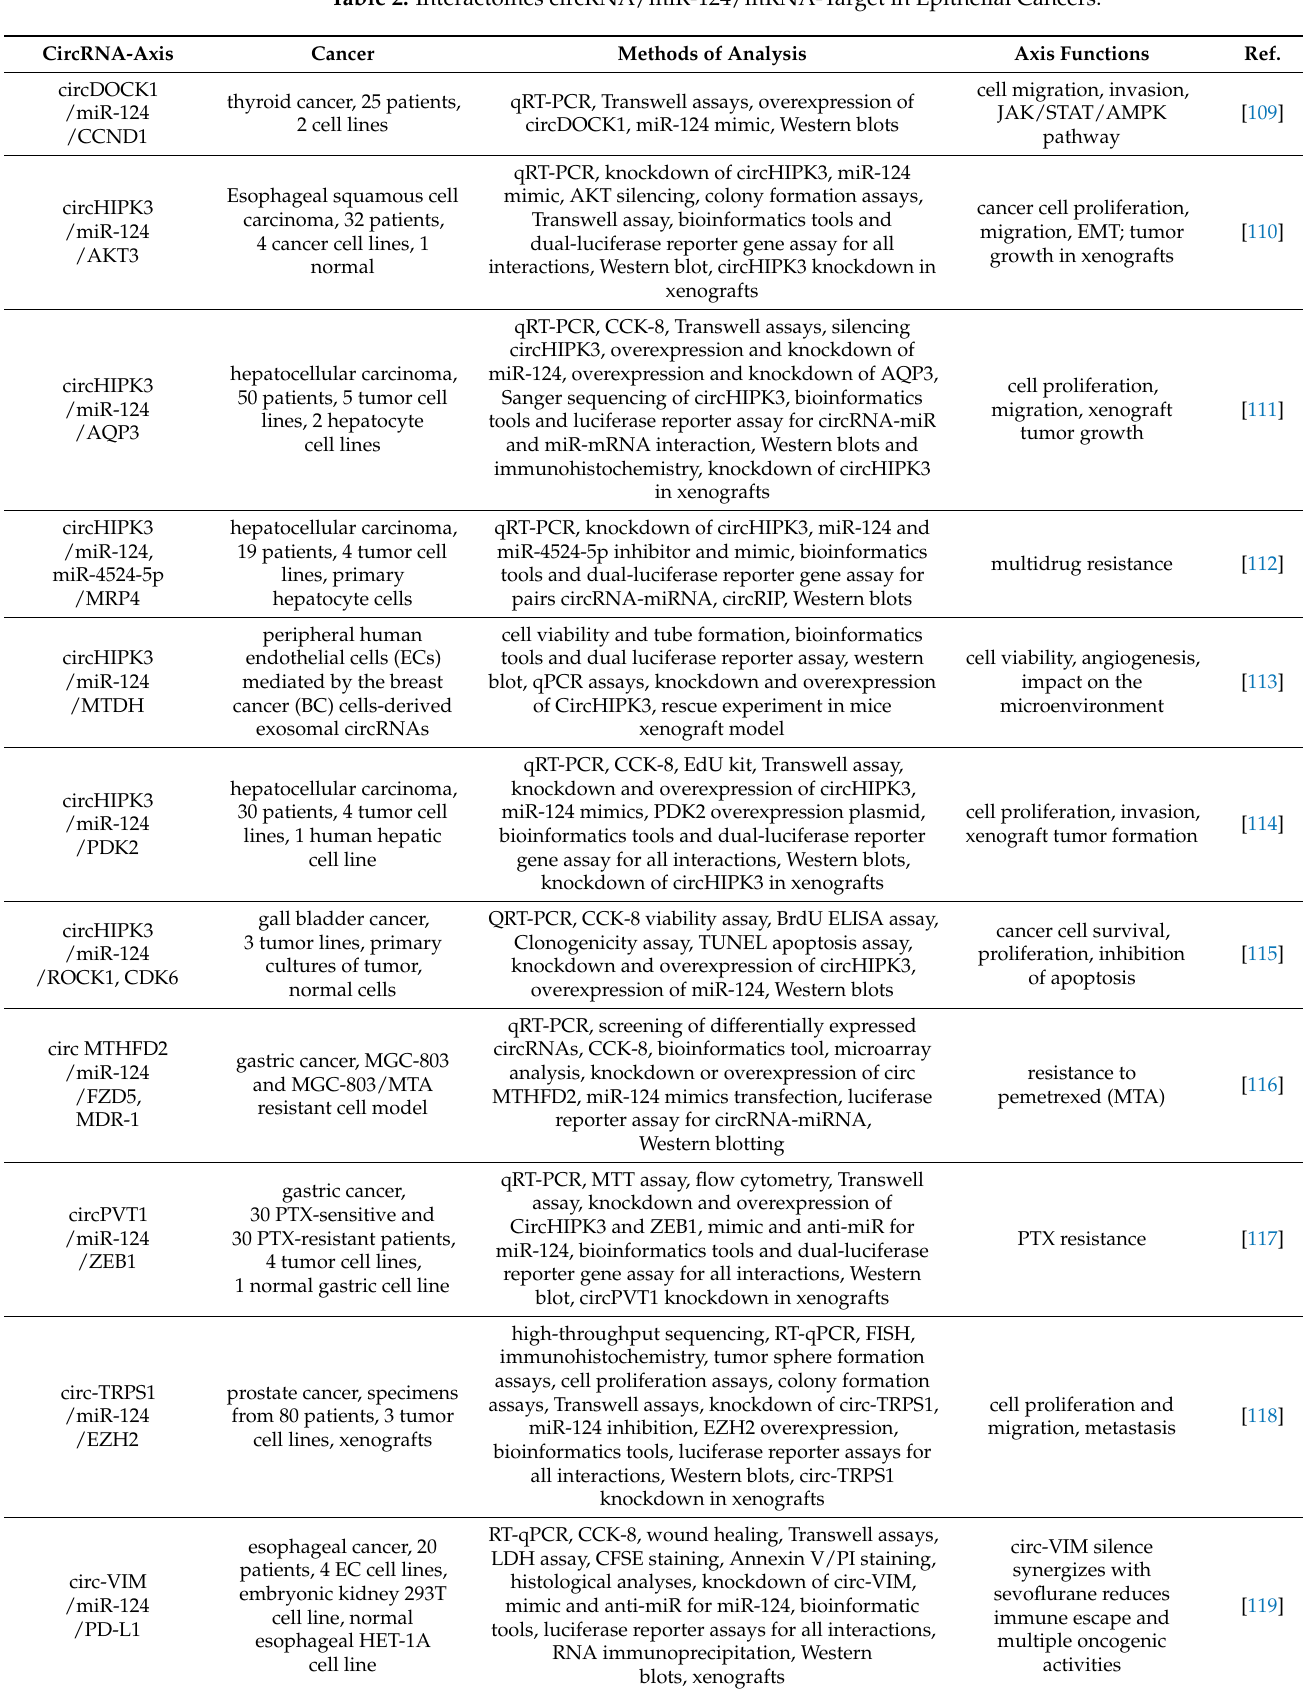
Table 2. Interactomes circRNA/miR-124/mRNA-Target in Epithelial